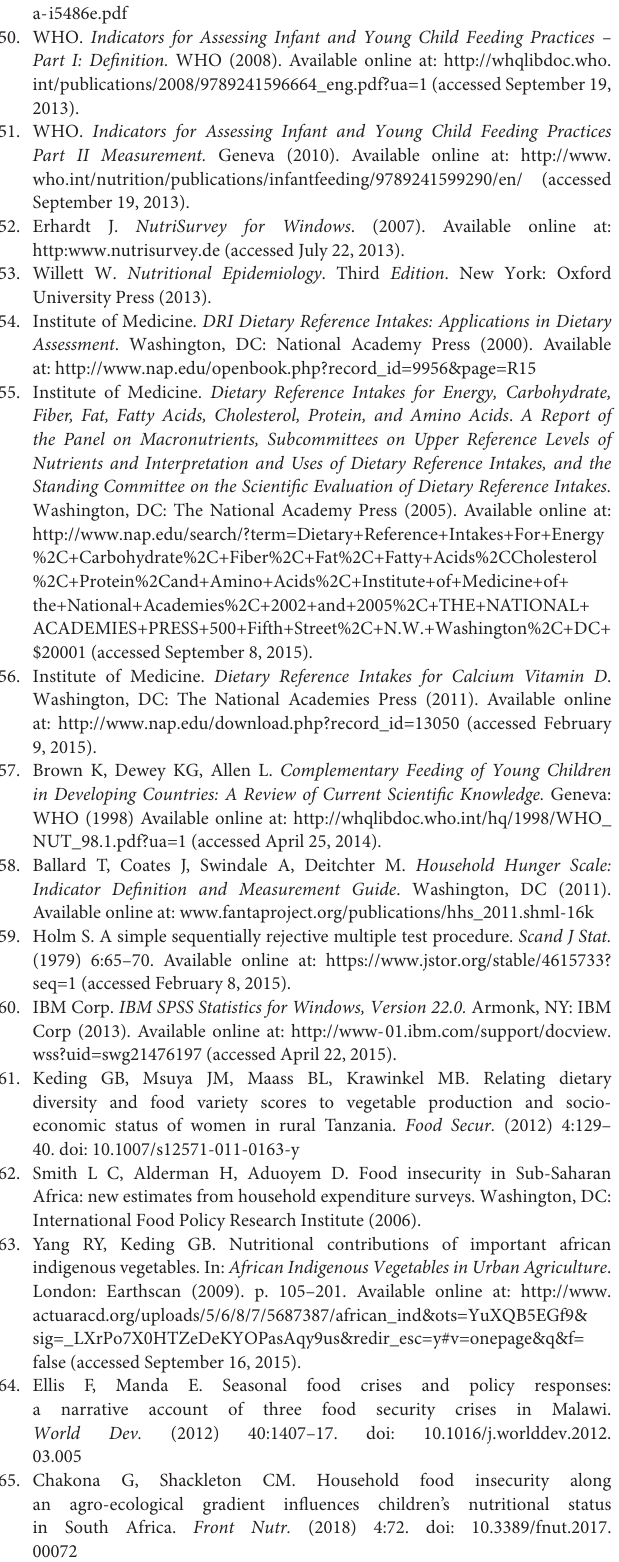
Vihiga district, Kenya: key determinants using an almost ideal demand system (AIDS). In: Agrarian vs. Rural: Economies and Settlements . Kenya: